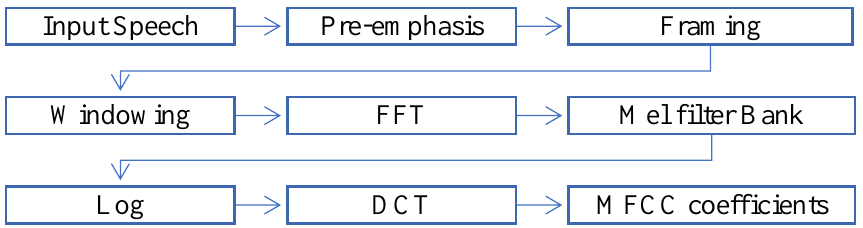
Figure 8. MFCC Feature extraction.